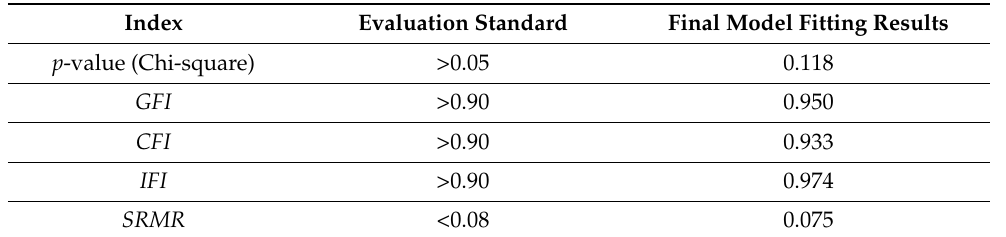
Table A1. Fitting index standard.